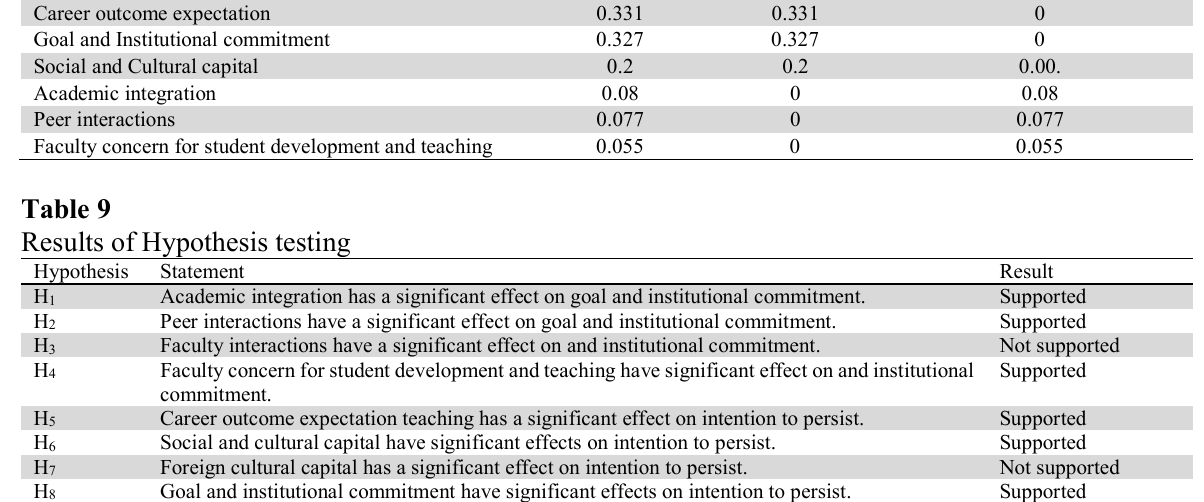
Standardized total/direct/indirect effects on Intention to persist Construct